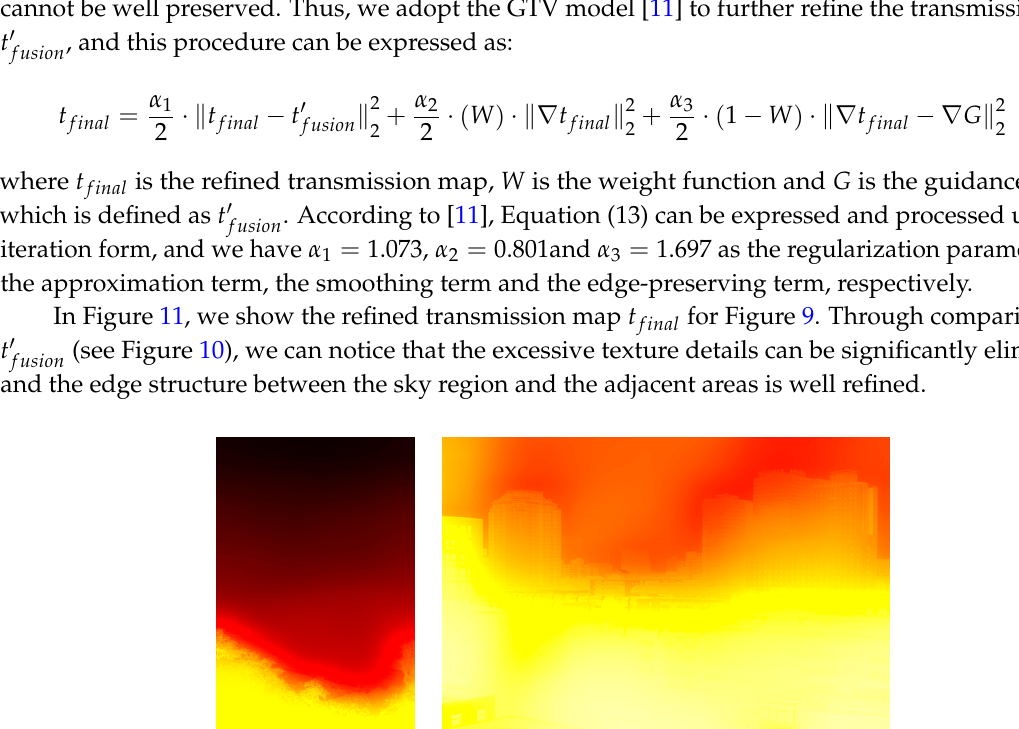
Figure 11. The refined transmission maps t final for Figure 9 via the GTV model. Left: The refined transmission map t final for the hazy image of Figure 9a. Right: The refined transmission map t final for the hazy image of Figure 9b.